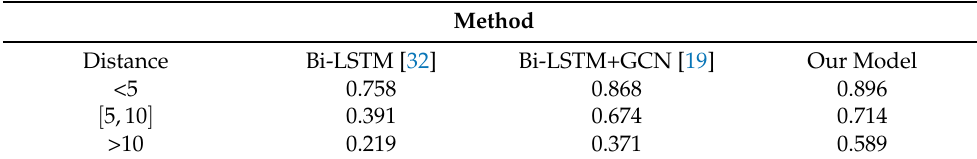
Table 4. Effects of different causal entity distances on